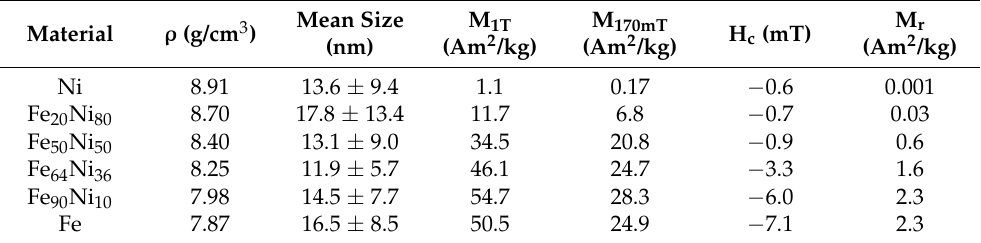
Table 2. Density and magnetic properties of different iron-nickel alloys extracted from the hysteresis curve in Figure